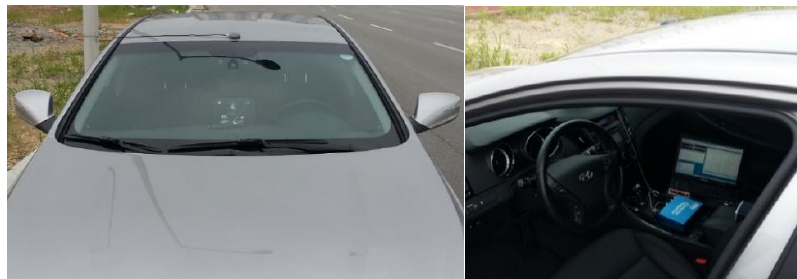
Figure 11. Experimental setup for steering pull measurement. Table 2. Specifications of measurement